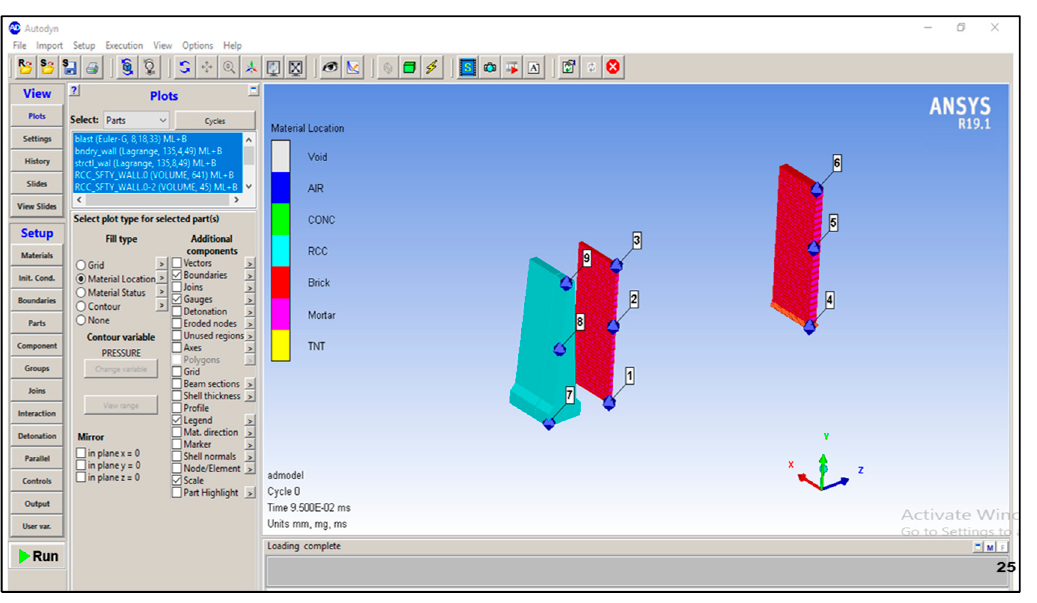
Figure 4. Gauges placed at the top, middle and bottom.